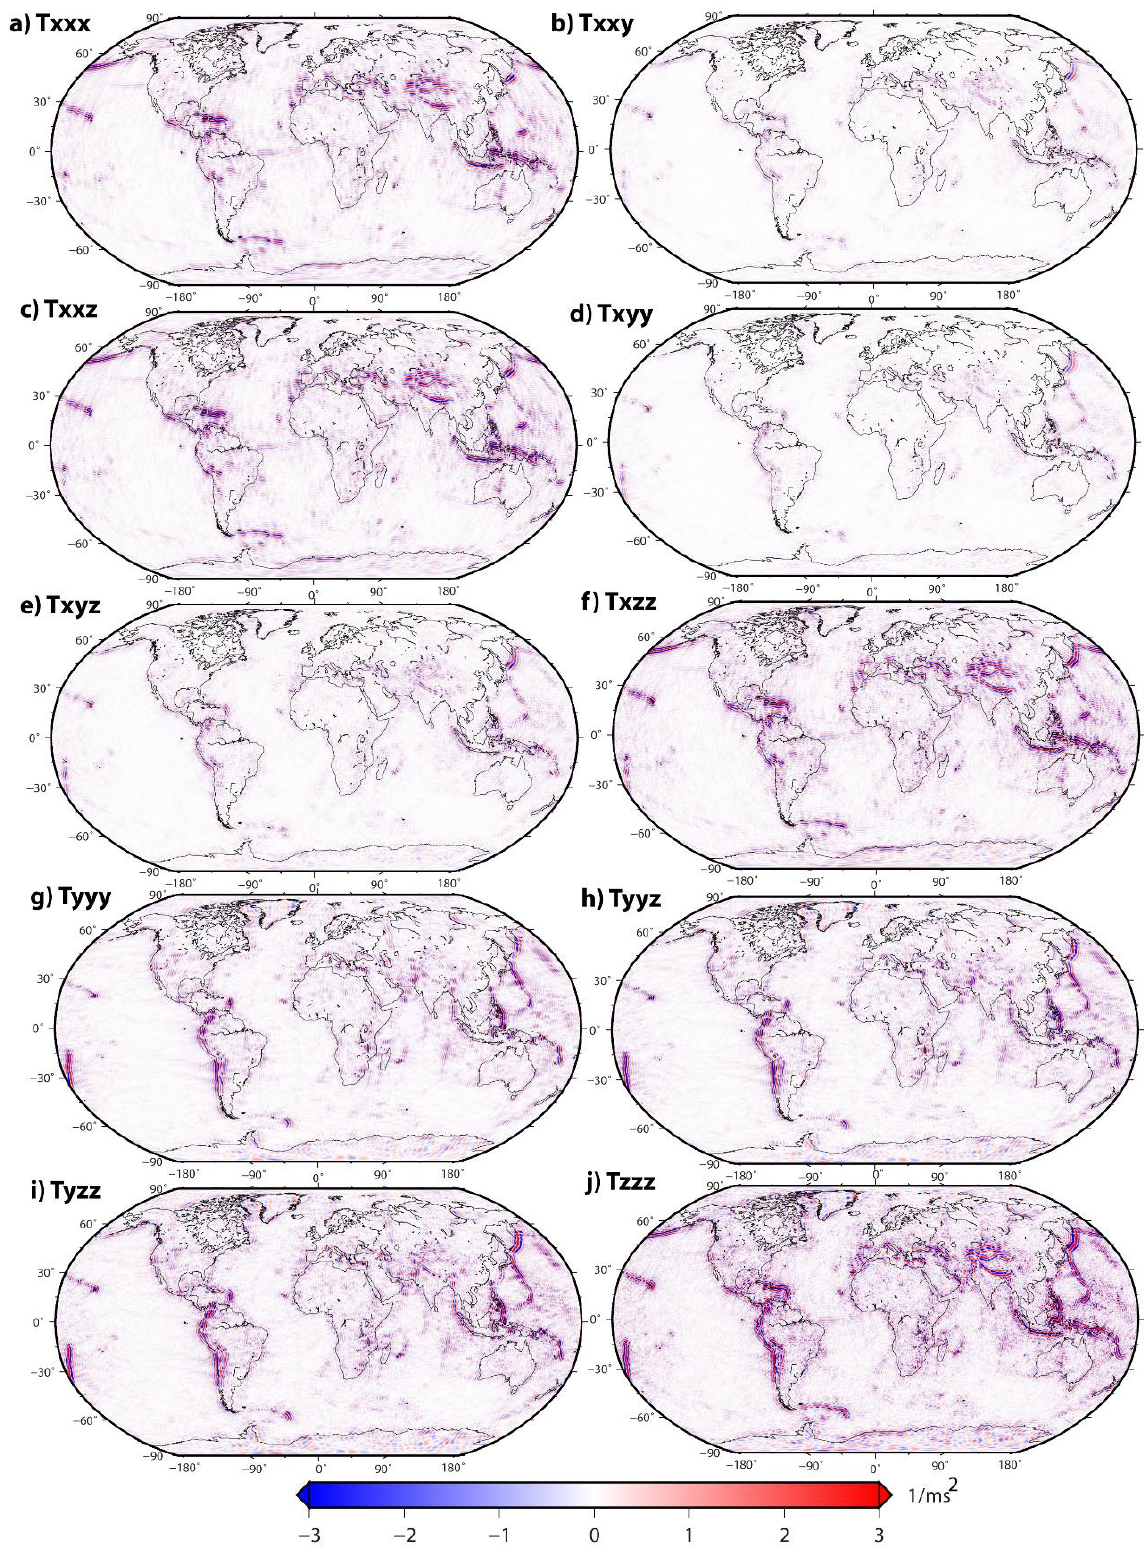
Figure 1. Maps of the third-order gradients synthesized from the EIGEN-6C model to degree and order 360. The GRS80 model is used as the normal